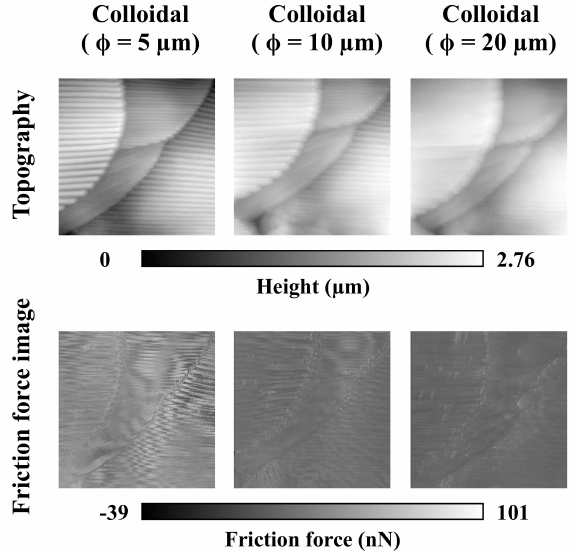
Figure 5. Topographies and friction force images obtained by AFM with three types of colloidal probe. Scanning direction was scale base to apex only. The body part measured was the